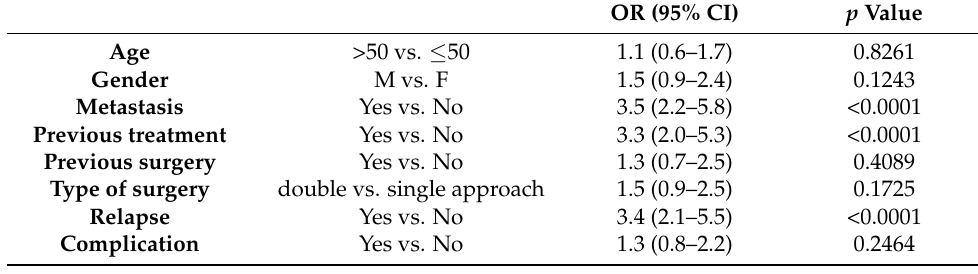
Table 7. Results from univariate Cox model for OS.